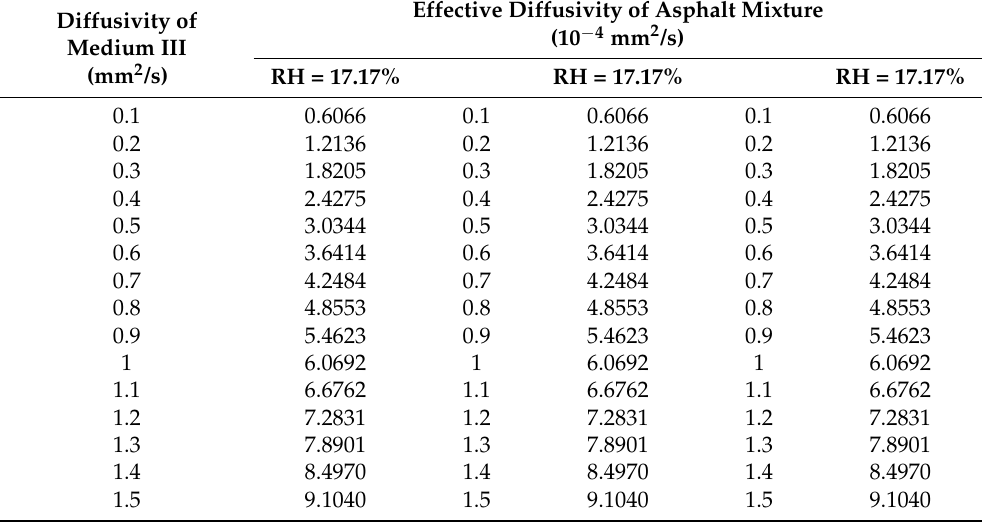
Table 10. Functional relationship between the effective diffusivities and the diffusivities of medium